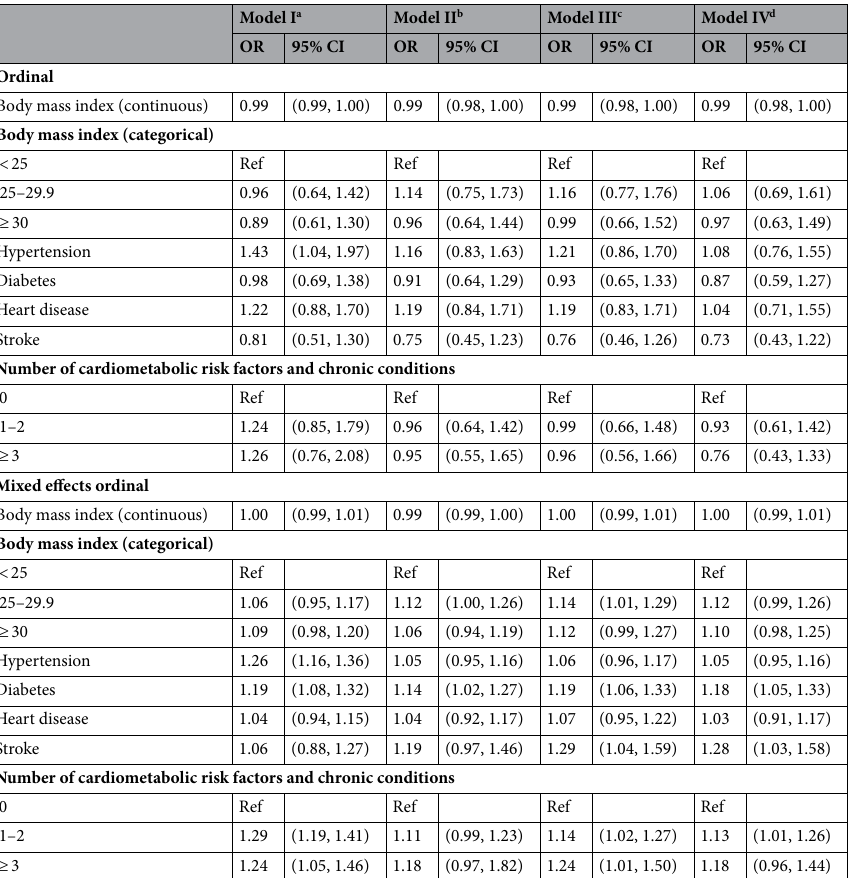
Table 1. Ordinal logistic regression and mixed effects ordinal logistic regression models for each obesity- related cardiometabolic risk factor and chronic condition as a predictor of Covid-19 level of concern before and after controlling for socio-demographic, lifestyle and health characteristics—2020 Health and Retirement Study enhanced interviewing Covid-19 half-sample. a Model I is unadjusted. b Model II is adjusted for socio- demographic characteristics. c Model III is adjusted for socio-demographic and lifestyle characteristics. d Model IV is adjusted for socio-demographic, lifestyle and health